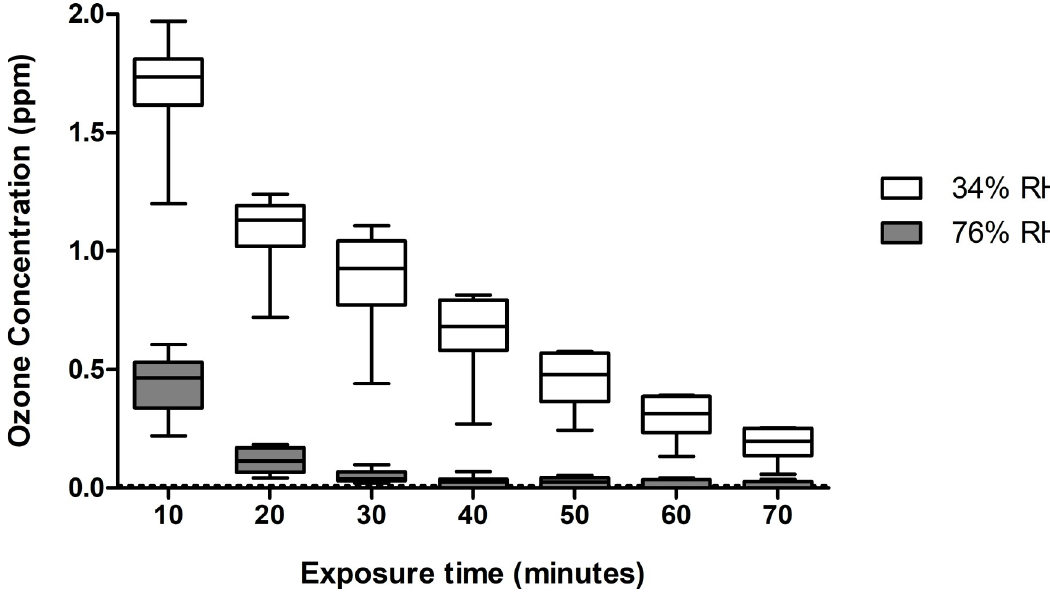
Fig 1. Ozone concentrations measured at 34% and 76% RH at 10-min intervals over a maximum exposure time of 70 min. The boxes at 10 minutes of exposure represent a total of 18 readings for both RHs. Boxes at 20, 30 and 40 min represent twelve readings each and boxes at 50, 60 and 70 min represent six readings